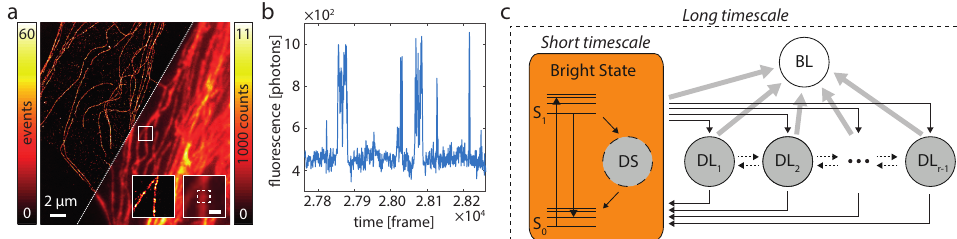
Figure 2. Fluorophore switching and diagram of states. ( a ) SMS (left) and widefield image (right) of Alexa 647-labeled microtubulular network. The insets show the respective images of the marked region (white box). The inset scale bar marks 500 nm. ( b ) During SMS imaging the fluorescence signal, e.g., within the white dashed box in the inset of A, fluctuates. This is due to switching of the fluorophore(s) between bright an dark states. ( c ) The general HTMM is separated into a long-timescale and a short-timescale model. Dynamics on timescales < t exp are subsumed in the short-timescale model which is treated in the long-timescale model as a single bright state (orange). Excited fluorophores emit either a fluorescence photon by a transition from S 1 to S 0 or enter the short-lived dark state DS. The long-timescale model treats dynamics on timescales ≥ t exp and exhibits the bright, one bleached (BL) and r − 1 dark states DL. Note that the bleached state can never be left and that transitions between the dark states DL are not limited to the ones depicted by the dotted arrows, but can occur between all states